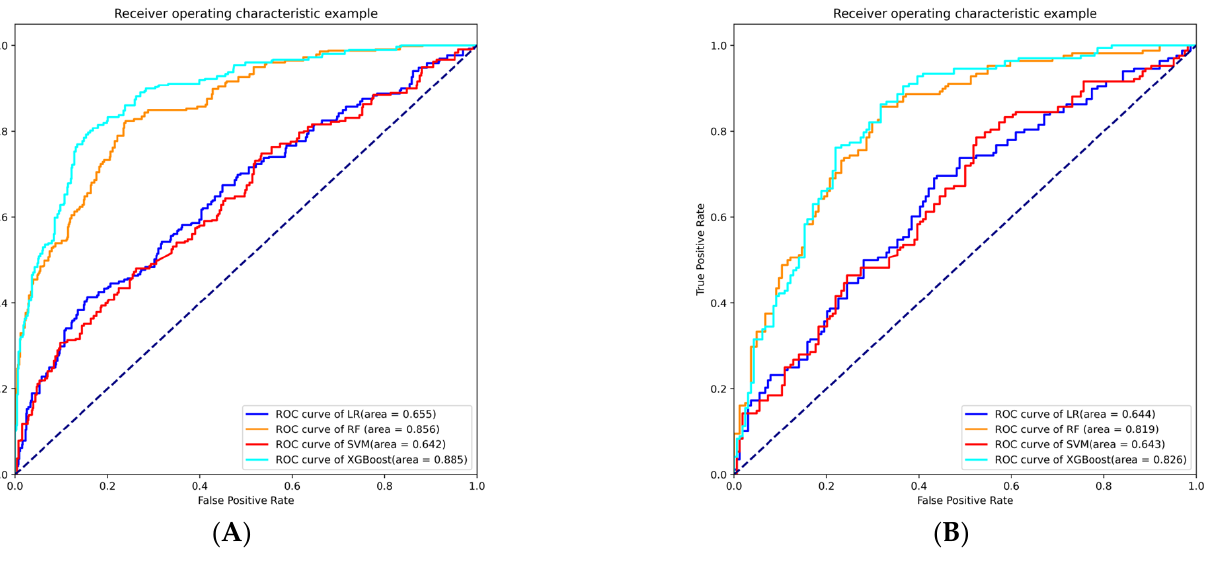
Figure 2. The receiver operating characteristic curve (ROC) of five models on training set ( A ) and ROC of five models on testing set ( B ). LR, logistic regression; RF, random forest; SVM, support vector machine; XGBoost, extreme gradient boosting. Table 2. Discrimination and calibration of each machine learning algorithm on the testing set.